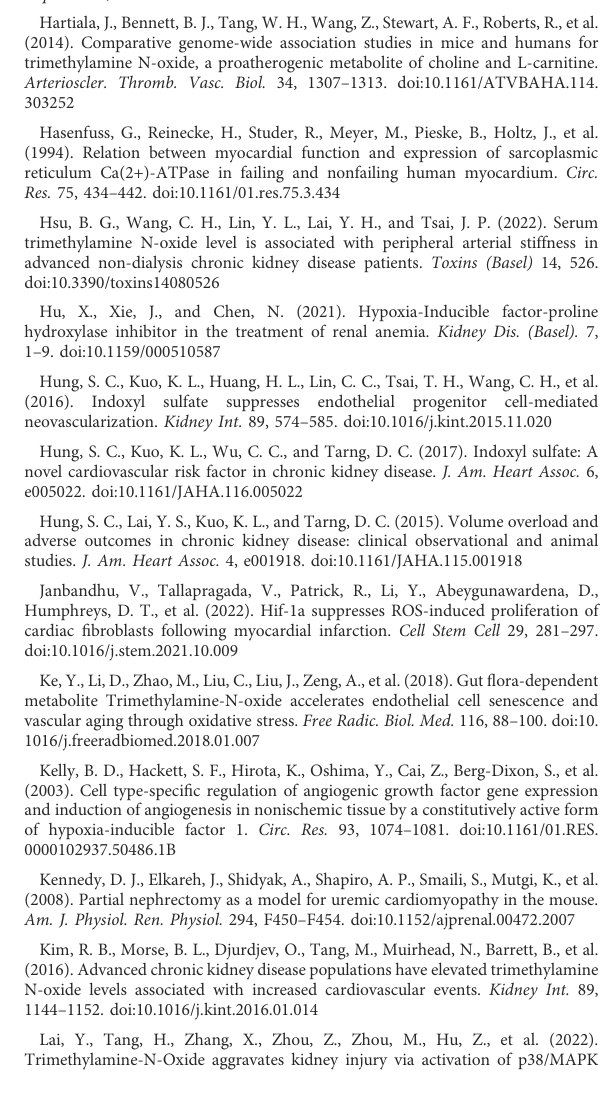
50 μ m) show the morphology of kidney. (F) Tubular injury score. (G) The fi brotic region (blue stain) quanti fi ed as the percentage of the total area. The data are presented as the mean ± SD. * p < 0.05 and ** p < 0.01 vs. CON group. n = 6 in each group. SUPPLEMENTARY FIGURE S3 Dietary choline (1.2%) does not affect cardiac function and morphology in CD1 mice. (A) Representative M-mode echocardiograms for each group. (B – G) Echocardiographic quanti fi cation of LVEF, LVFS, LVESV, LVESV, LVESD, and LVEDD. (H) Photomicrographs of left ventricular tissue sections stained with hematoxylin and eosin (H&E). (I – L) The mRNA levels of β -MHC, ANP, BNP, and SERCA2a were measured by real-time PCR. (M) The protein levels of SERCA2 were measured by western blotting. (N) Graphic representation of relative abundance of SERCA2 normalized to GAPDH. The data are presented as the mean ± SD. * p < 0.05 and ** p < 0.01 vs. CON group. n = 6 in each group.